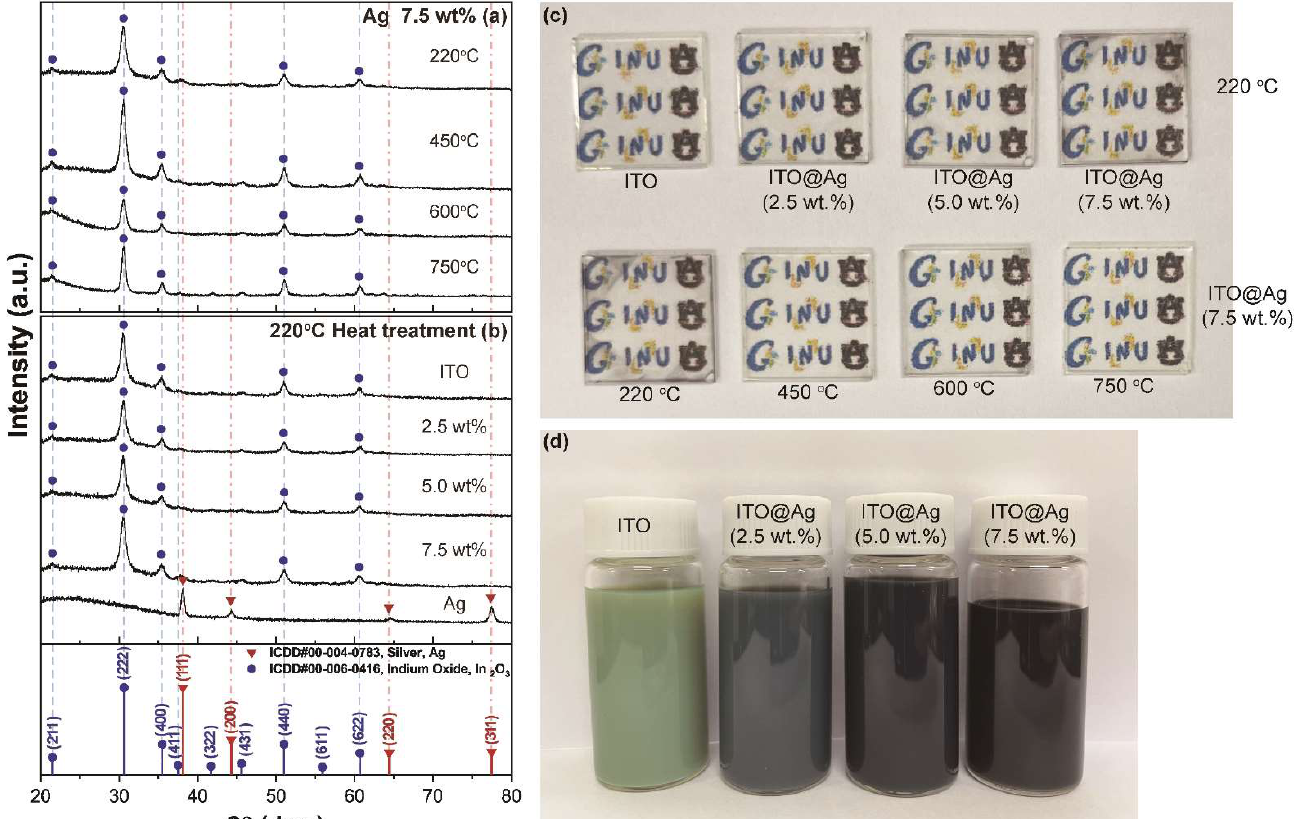
Figure 1. XRD patterns of ITO@Ag (7.5 wt.%) thin films according to ( a ) thermal-treatment temper- ature, ( b ) thin films heat-treated at 220 °C according to the weight percentage of silver, and ICDD PDF data of Ag (00-004-0783) and In 2 O 3 (00-006-0416) ( c ) photograph of the deposited electrodes according to the weight percentage of silver and thermal-treatment temperature, ( d ) photograph of colloidal ITO and ITO@Ag ink.